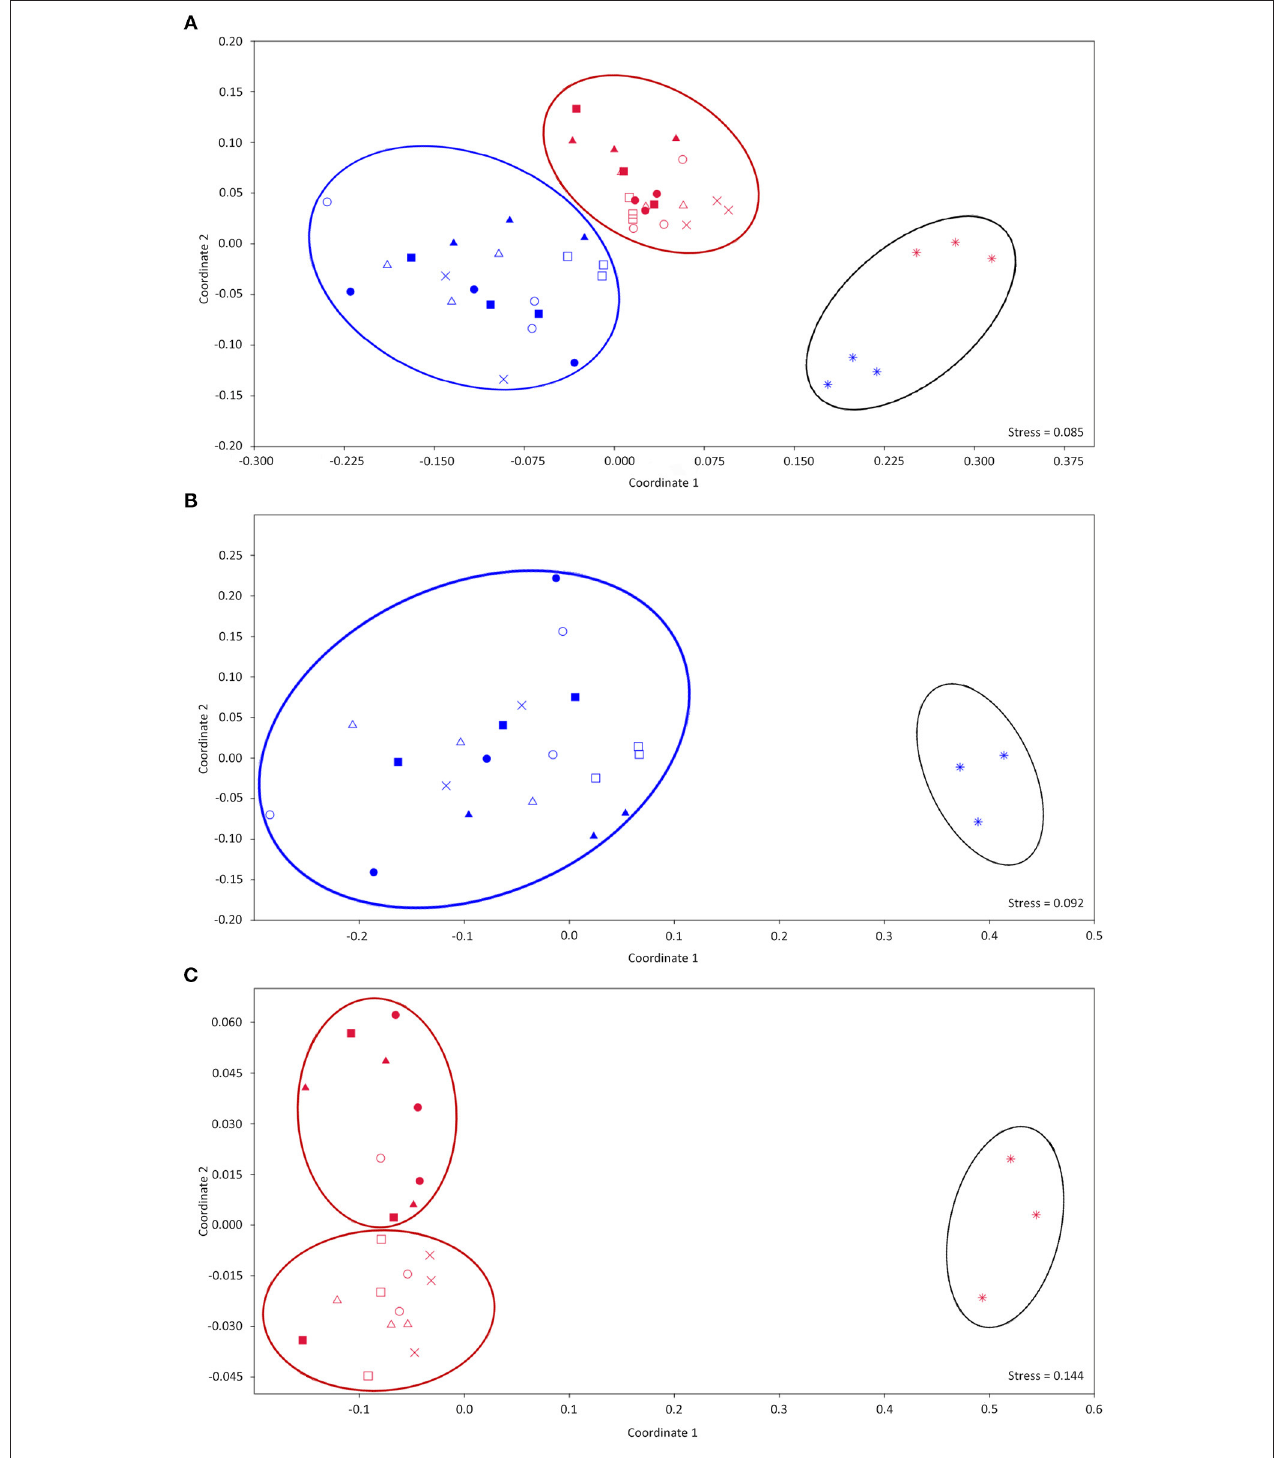
FIGURE 3 | Non-metric multidimensional scaling (NMDS) ordination diagram based on the OTU-generated matrices obtained after sequencing using primers for the 16S rRNA-coding gene. (A) All samples analyzed together, (B) Samples taken 60 days after sowing, and (C) Samples taken 90 days after sowing. *, Bulk soil; × , 0_P2O5; (cid:3) , 130 kg_STP_PL; (cid:4) , 260 kg_STP_PL; 1 , 130 kg_BAY_PL; N , 260 kg_BAY_PL; ◦ , 130 kg_STP; •, 260 kg_STP; blue and red colors represent 60 and 90 days after sowing, respectively.